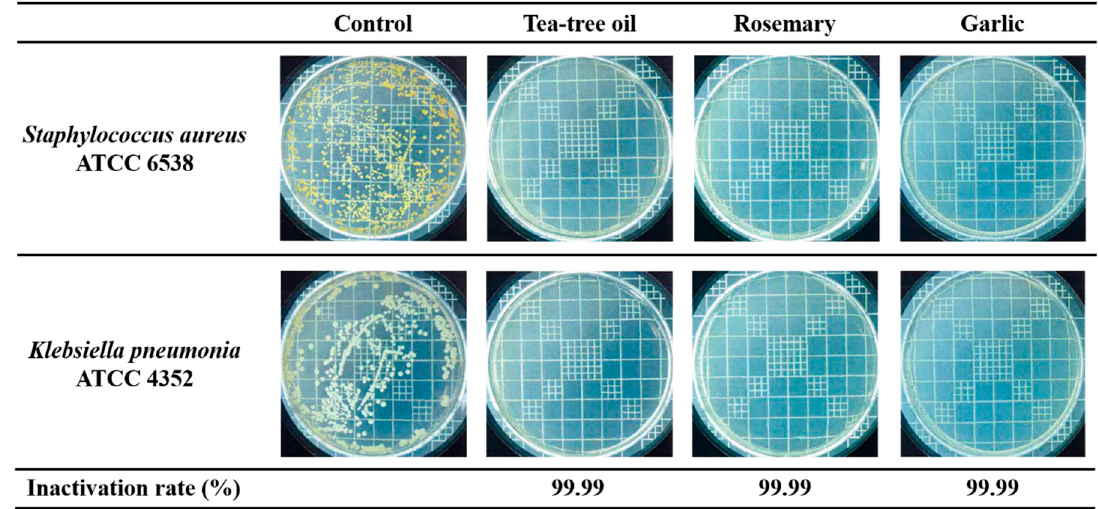
Figure 4. Images of the anti-pathogen activity of air filter samples for S. aureus and K. pneumonia.